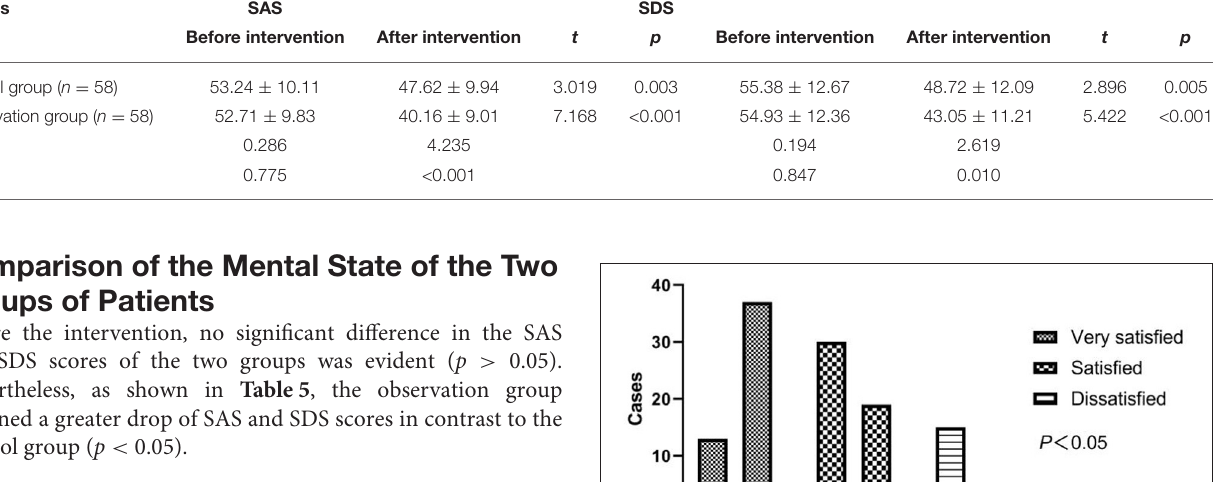
TABLE 5 | Comparison of Self-Rating Anxiety Scale (SAS) and Self-Rating Depression Scale (SDS) scores between the two groups of patients (¯x ± s, points). Groups SAS SDS Before intervention After intervention t p Before intervention After intervention t p Control group ( n = 58)